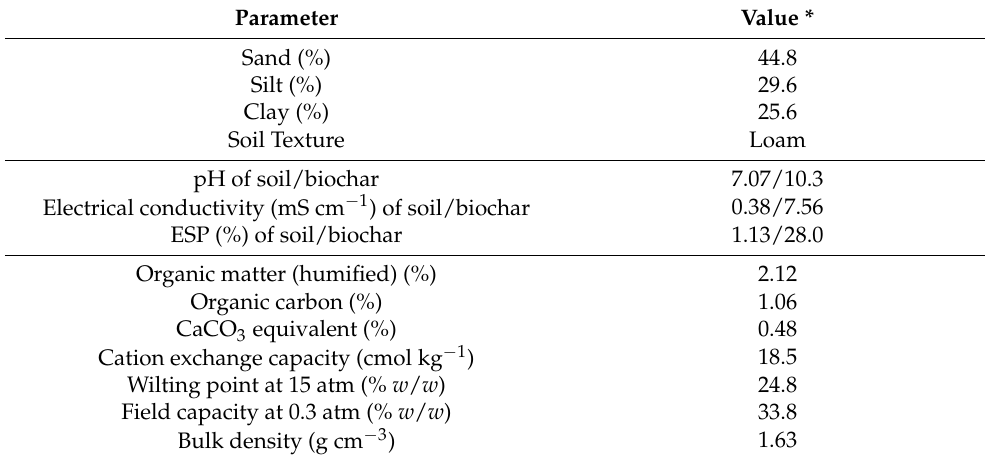
Table 1. Main physicochemical characteristics of the agricultural